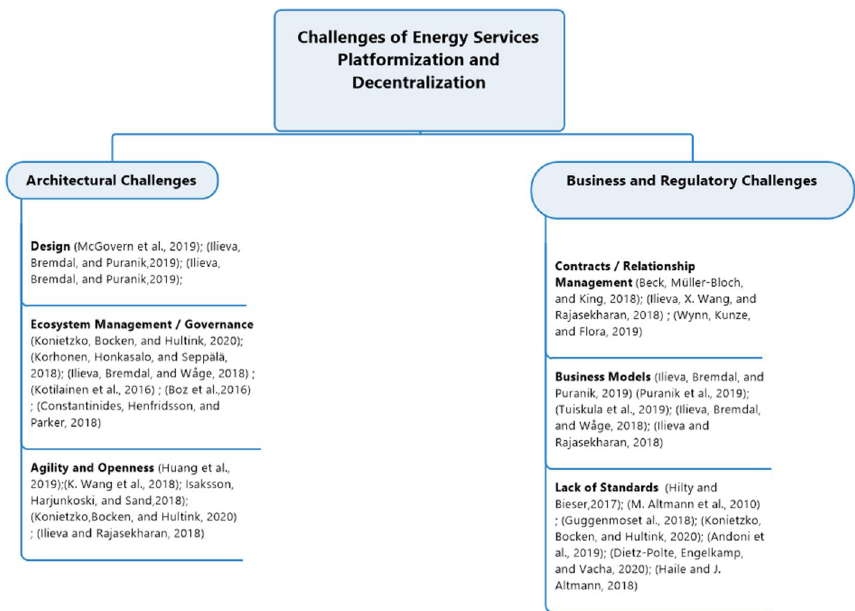
Fig. 3 Systematic literature review findings and